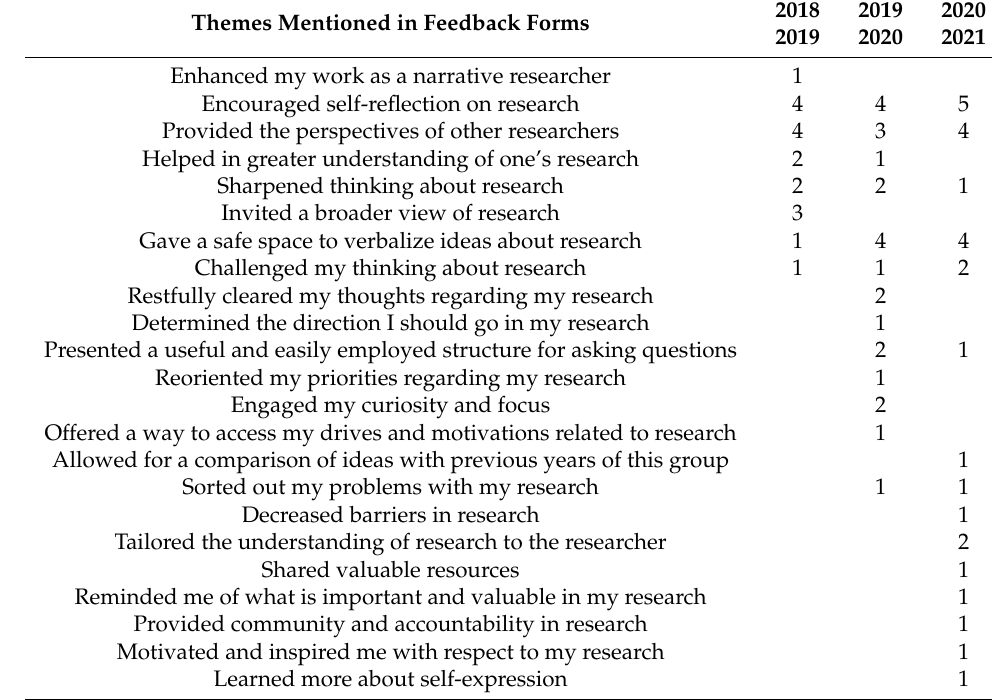
Table 8. Themes Mentioned in Responses Provided on the April Feedback Forms to How Was the Group Valuable to You as a Researcher? For Each of the Three Most Recent Academic Years in Order of Receipt of Feedback Forms from Group